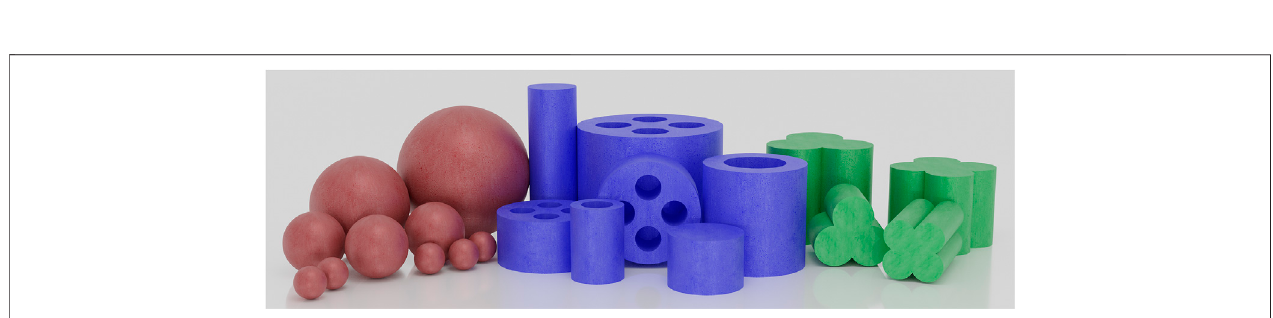
FIGURE 2 | Impression of different conventional catalyst bodies for dense randomly packed beds; spherical particles in red, cylinder-like pellets in blue and multi- lobe structures in green.